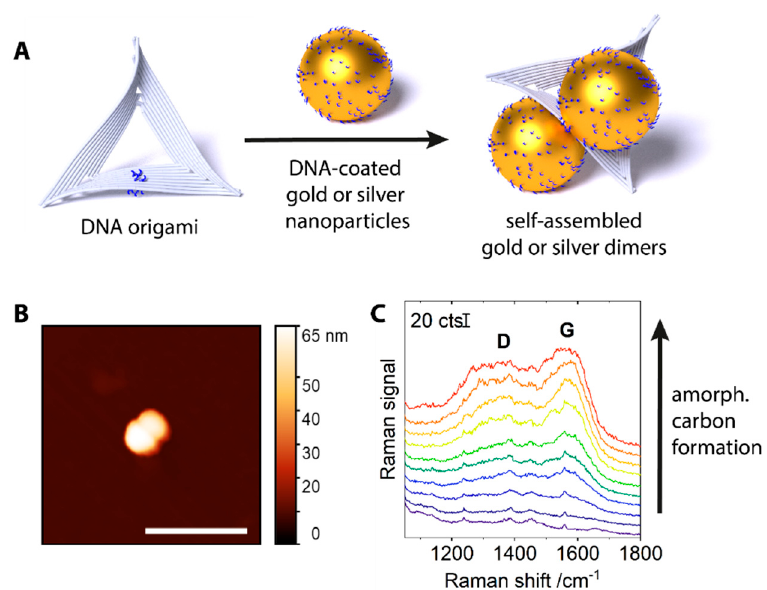
Figure 1. ( A ) Assembly scheme for 60 nm gold and silver dimers. ( B ) Atomic force microscopy (AFM) image of a gold dimer. Scale bar: 300 nm. ( C ) Average SERS signals of consecutive scans over an area of 170 × 190 µ m 2 with 60 nm silver dimers, demonstrating the gradual increase of the amorphous carbon signal (bottom to top, D and G band annotated, 532 nm irradiation, 450 kW cm − 2 , 0.2 s integration per spot). Spectra are o ff set for clarity.